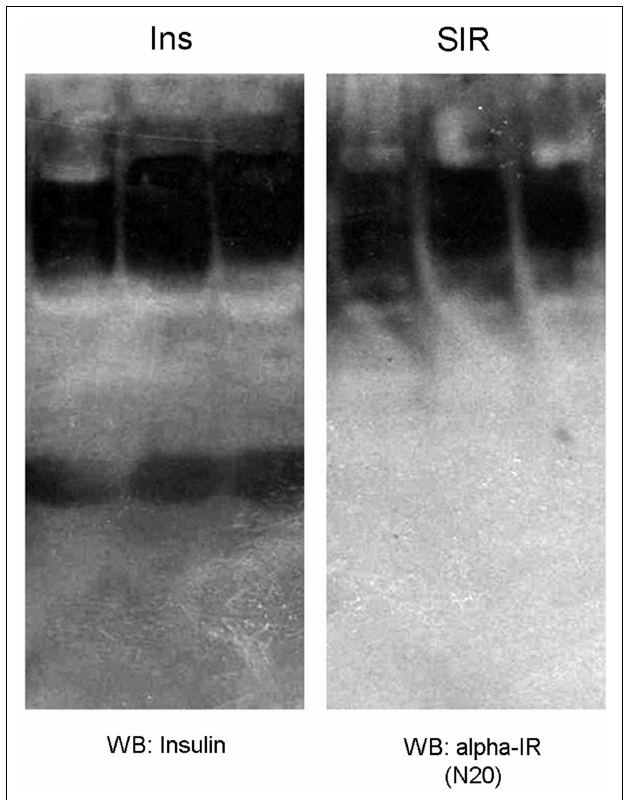
FIGURE 2 |Western blot against insulin (Ins) and a soluble insulin receptor (SIR) after native gel electrophoresis from plasma samples of three adult maleWistar rats . As observed, insulin and SIR bands migrated at the same position, which reflects the interaction between these molecules.